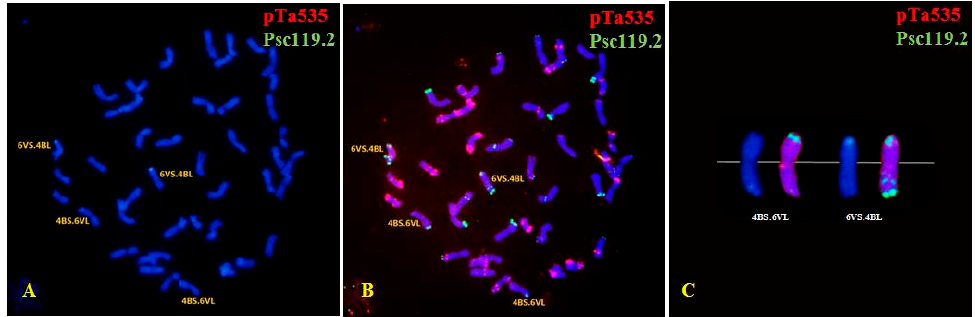
Figure 3. Cont. Figure 3. Cont .